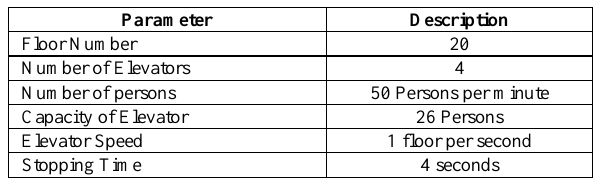
Table 2. Simulation